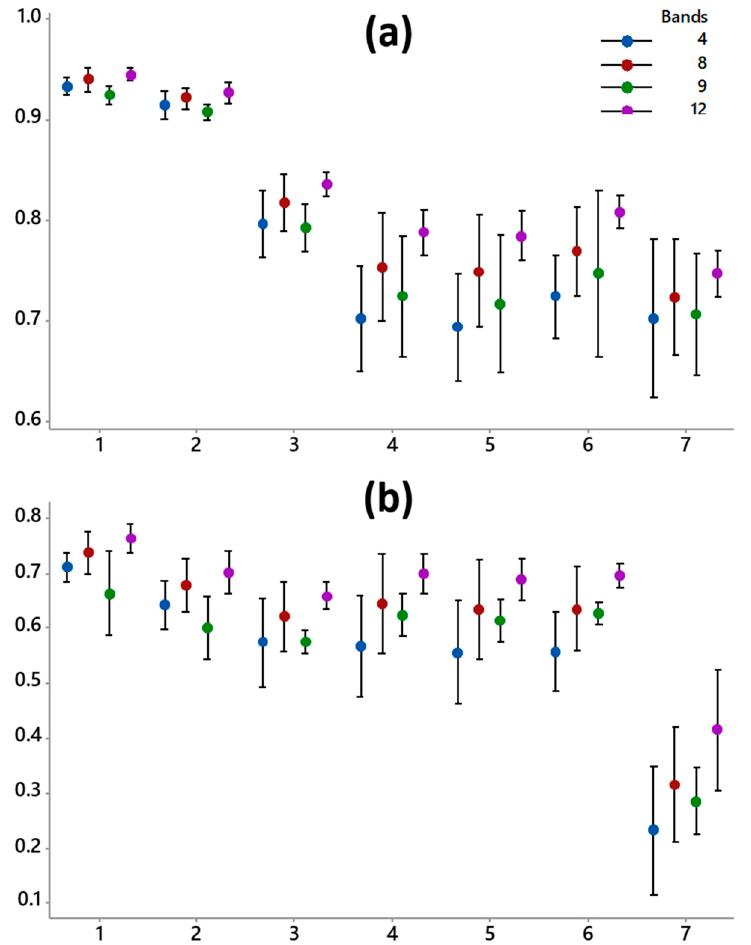
Figure 6. Interval plots from the pairwise post hoc test after applying the global approach variance analyses for the iteration between the level and band factors. ( a ) Results using OA as the numerical variable; ( b ) Results using kappa as the numerical variable.